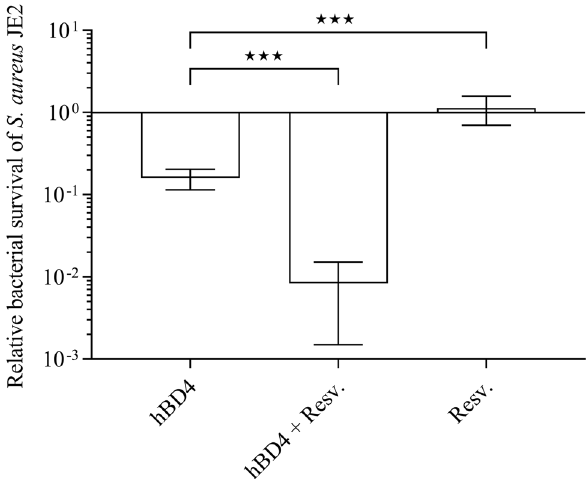
Figure 2. Resveratrol sensitizes S. aureus to hBD4. Survival of S. aureus JE2 was assessed for resveratrol (32 µg/ ml) and hBD4 (5 µM), either alone or in combination. Each value provided is the mean ± SEM derived from at least three independent measurements.